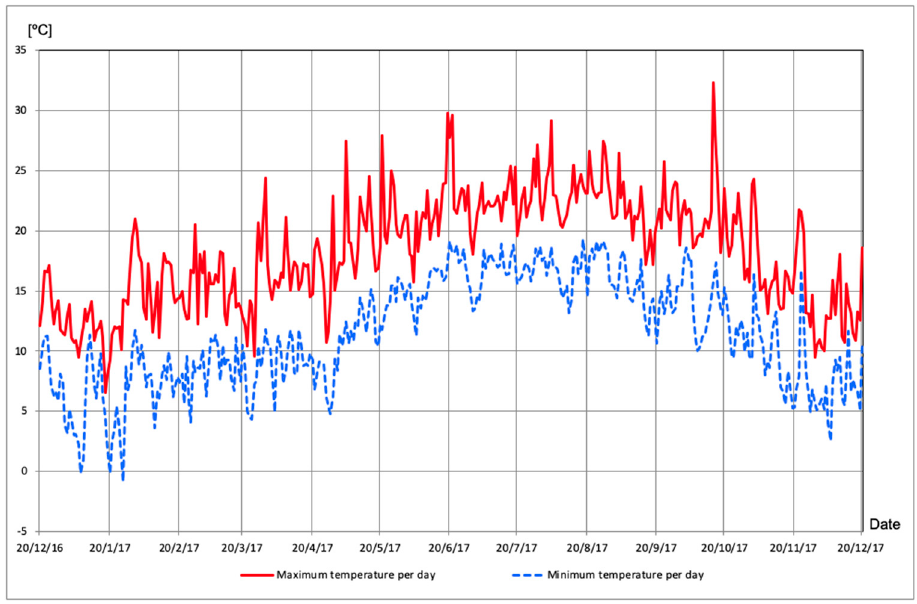
Figure 3. Maximum and minimum temperature per day in Santander for the year